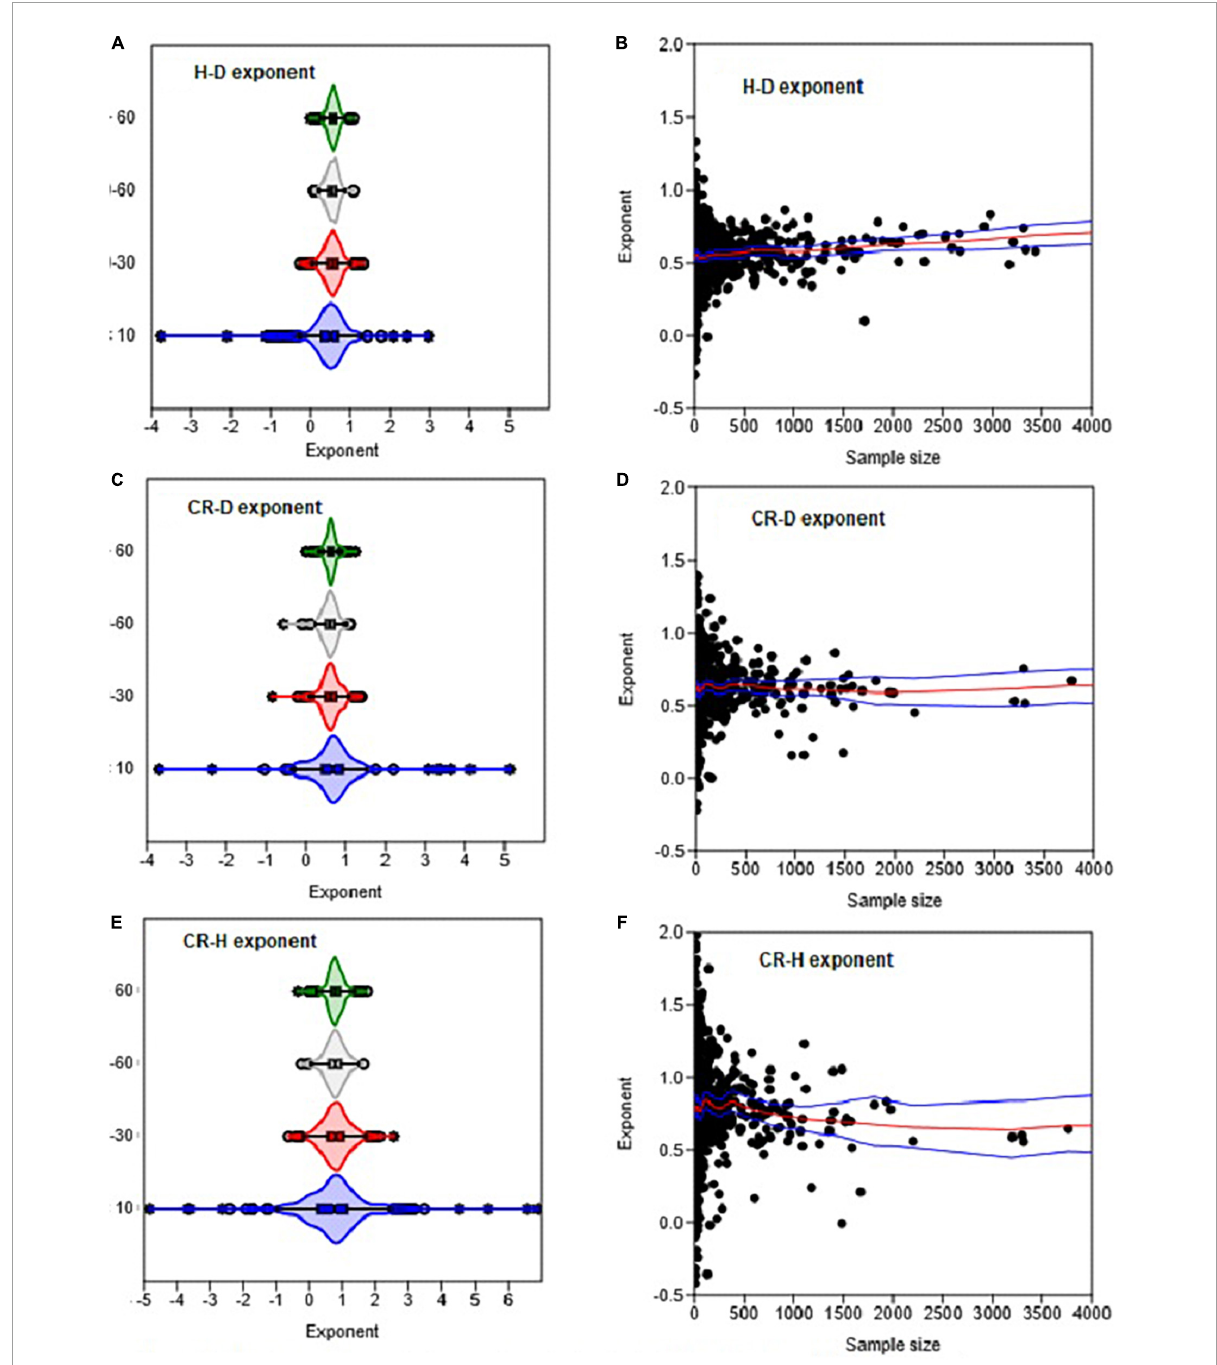
FIGURE8 The effects of sample size on the variation in the H–D, CR–D, and CR–H allometric exponents ( β ). Distributions in (A,C,E) are based on OLS estimates of the exponent for each genus. Each circle in (B,D,F) represents the estimate of the exponent of a genus. The box and whisker plots display the median and its 95% CI (notches), lower quartile, upper quartile, extreme values, and outliers (O and *). In (B,D,F) the red and blue lines represent the LOESS trend lines and their 95% confidence bands.